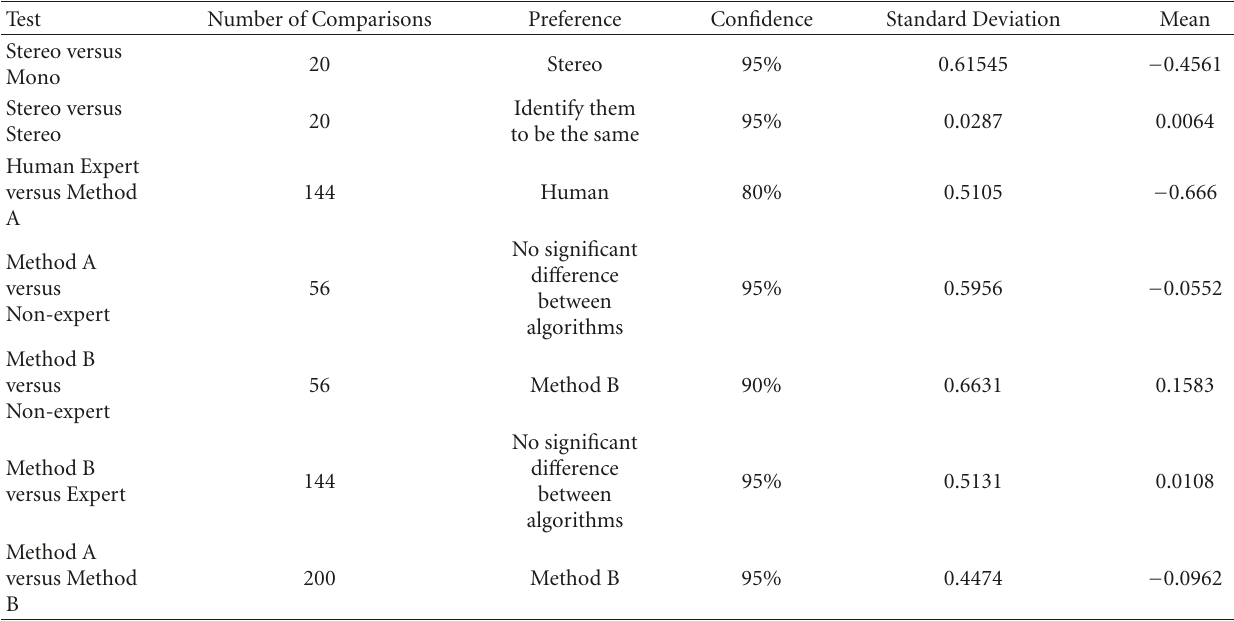
Table 1: Double blind panning quality evaluation